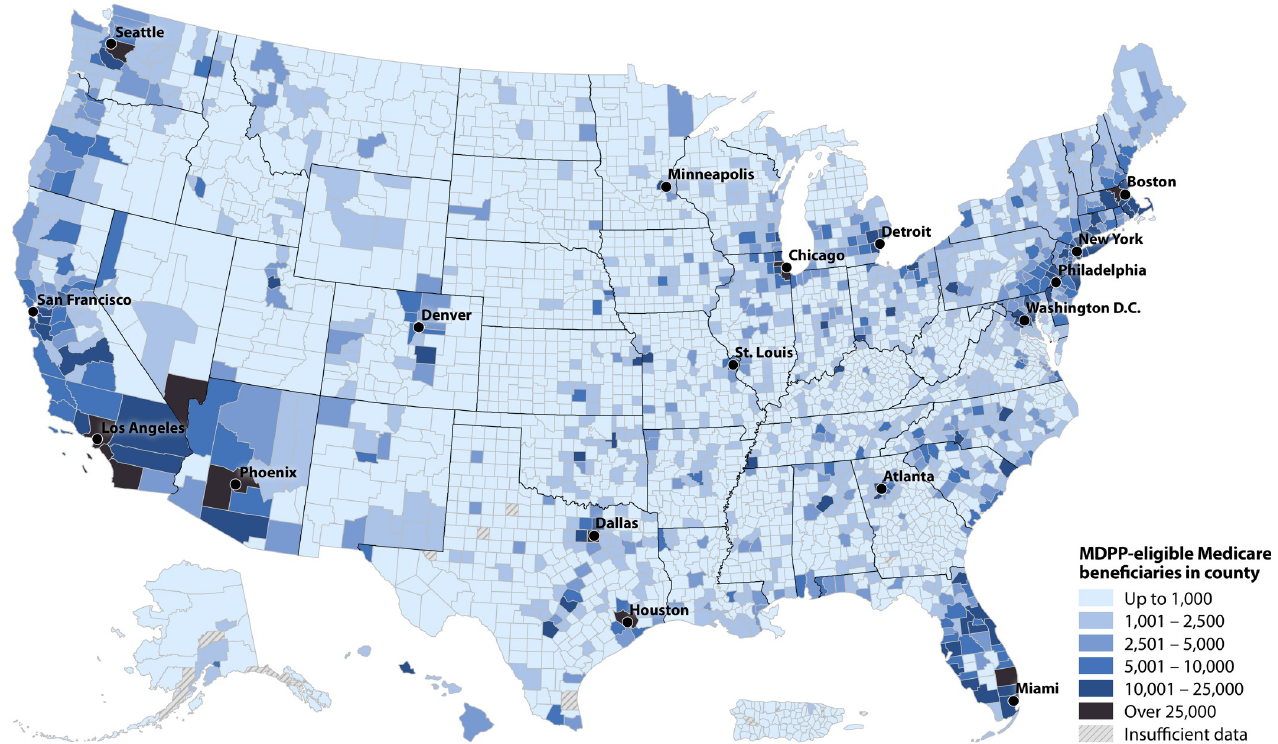
Fig 2. Estimated number of MDPP-eligible beneficiaries by county level, 2015.